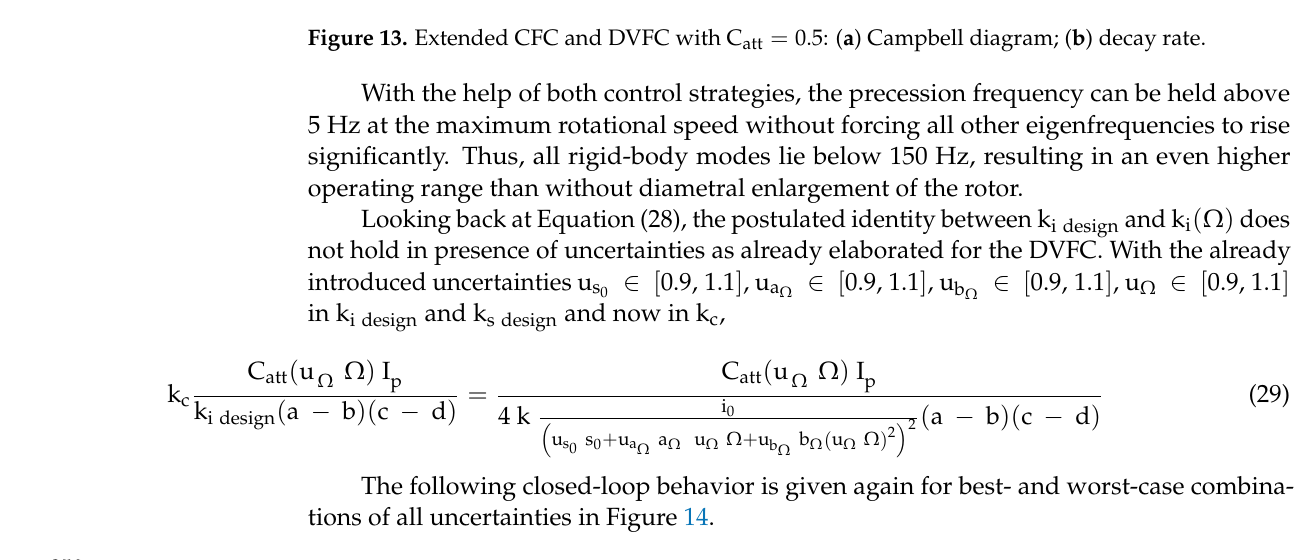
att = 0.5: ( a ) Campbell diagram; ( b ) decay rate.